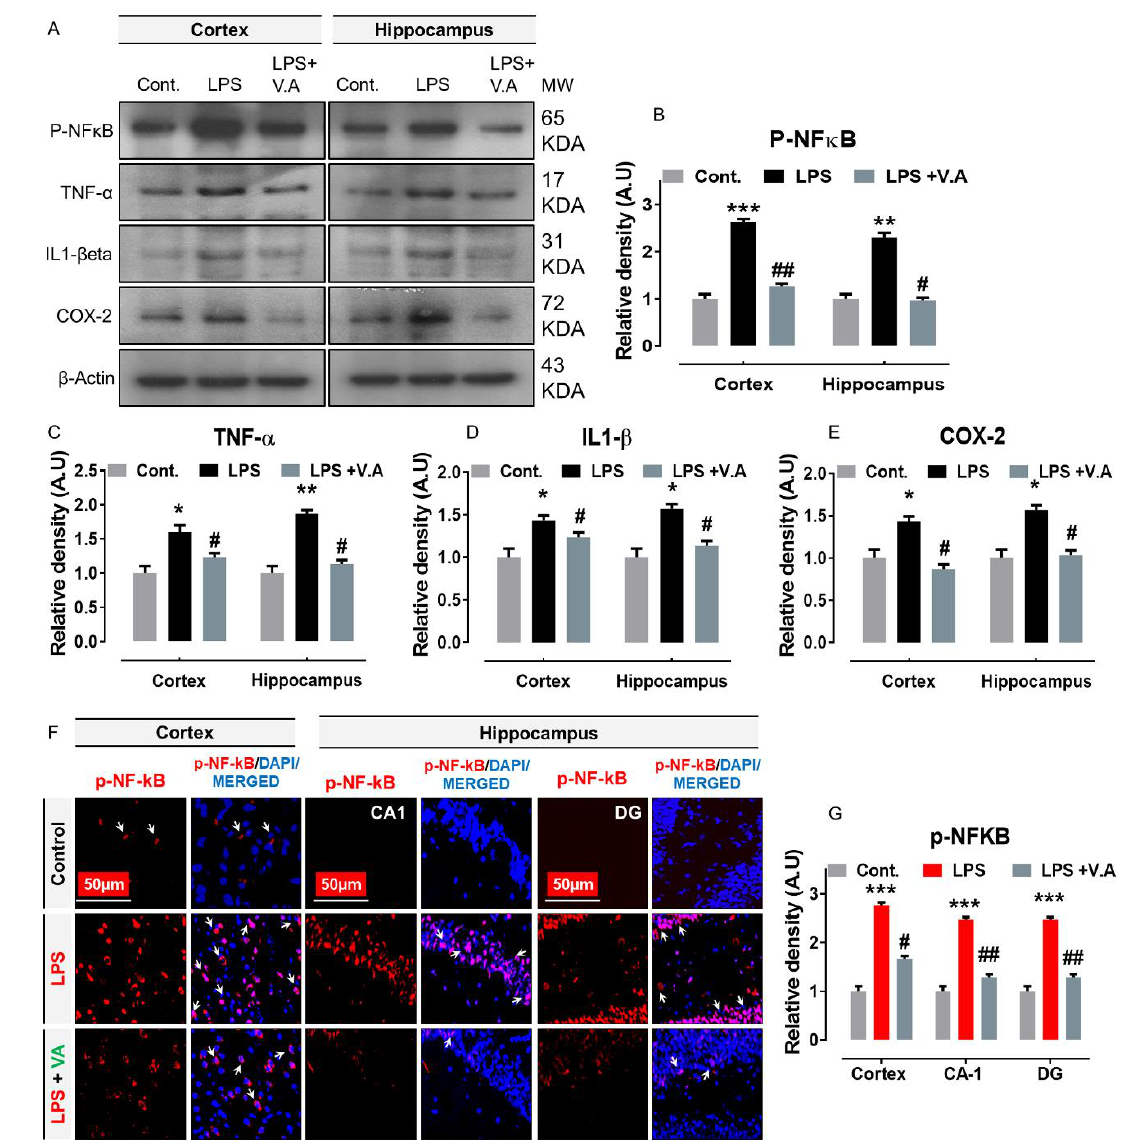
Figure 3. Vanillic acid treatment inhibited LPS-induced activation of nuclear factor nuclear factor-kappa B (p-NF-κB) and neuroinflammatory mediators/cytokines in mice brain. ( A–E ) the western blot bands of p-NF-κB, tumor necrosis factor alpha (TNF-α), interleukin-1 βeta (IL-1βeta), and cyclooxygenase-2 (COX-2) antibodies along with their relative histograms indicating their respective proteins expression level in both cortex and hippocampus regions of mice brain. The western blot bands were cropped and quantified using ImageJ software, and the differences are shown in the histogram. The relative density values were expressed in comparison with control in A.U. All values were taken as the mean ± SEM of three repeated/independent experiments for the respective indicated protein. As a loading control, an anti-β-actin antibody was used. n = 8 mice/group, and the number ( N ) of experiments performed ( N ) = 3. ( F,G ) the representative photomicrographs of immunofluorescence staining represent the immunoreactivity of p-NF-κB protein along with its relative histogram in different regions (cortex, CA1, and DG region) in various experimental brain groups (green, FITC; blue, DAPI). White small arrows indicated the desired signals of the tested antibody. The relative integrated density values were expressed in comparison with control in A.U. All values were taken as the means (± S.E.M) for the respective indicated proteins. For nucleus staining, DAPI (blue) was used. n = 8 mice/group, and the number ( N ) of experiments = N = 3. Magnification = 10×. Scale bar; cortices/DG hippocampal regions = 50 μm. Asterisk sign (*) indicated significant difference from the normal saline-treated (Cont.) group; hash sign (#) indicated significant difference from LPS-alone treated group; while the phi sign (Φ) indicated no significance from normal saline-treated (Cont.) group. Significance: * # = p ≤ 0.05, ** ## = p ≤ 0.01, and *** = p ≤ 0.001.